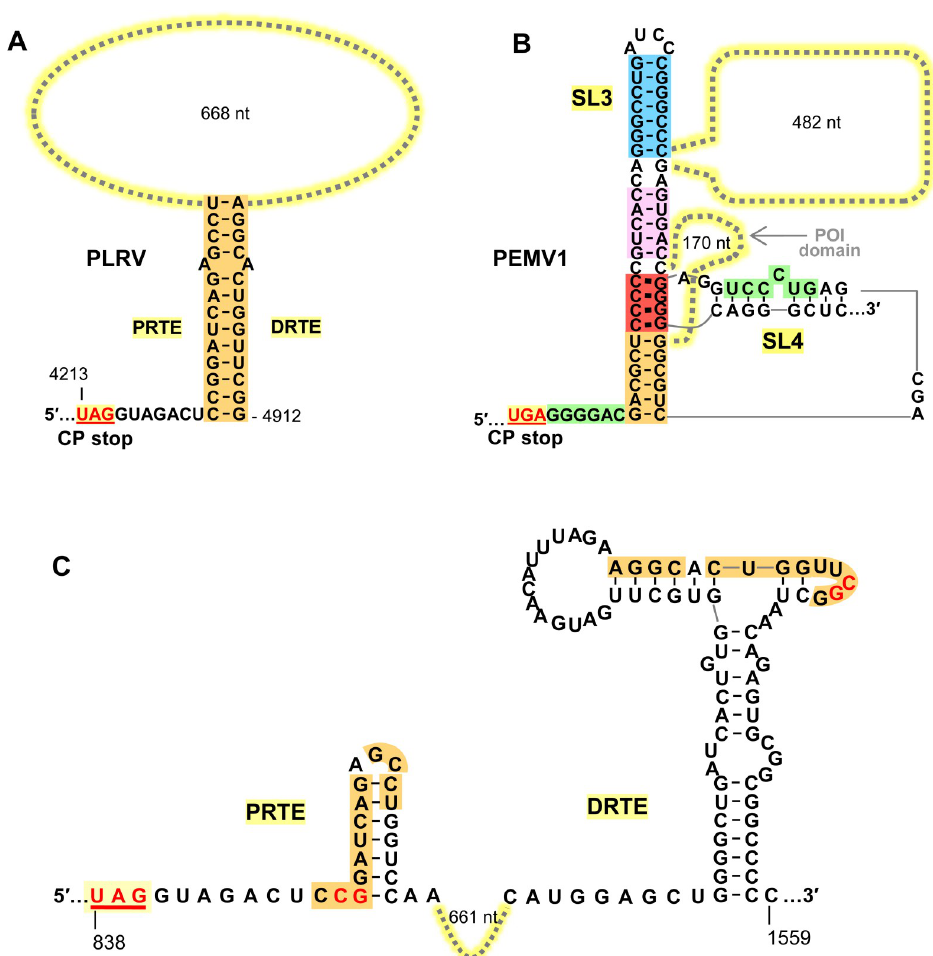
Fig 9. Comparison of PLRV and PEMV1 readthrough structures. (A) Predicted readthrough structure of PLRV showing the key orange PRTE/DRTE interaction. (B) Proposed readthrough structure for PEMV1, including local and long-distance interactions. (C) Predicted local RNA secondary structures for PRTE and DRTE [13] regions in PLRV. Nucleotides shown in red were targeted for compensatory mutational analysis in Fig 8.